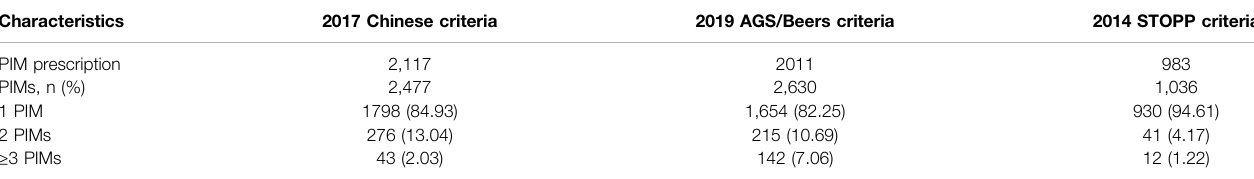
TABLE 3 | The number of PIMs used by older cancer outpatients in the PIM group. Characteristics